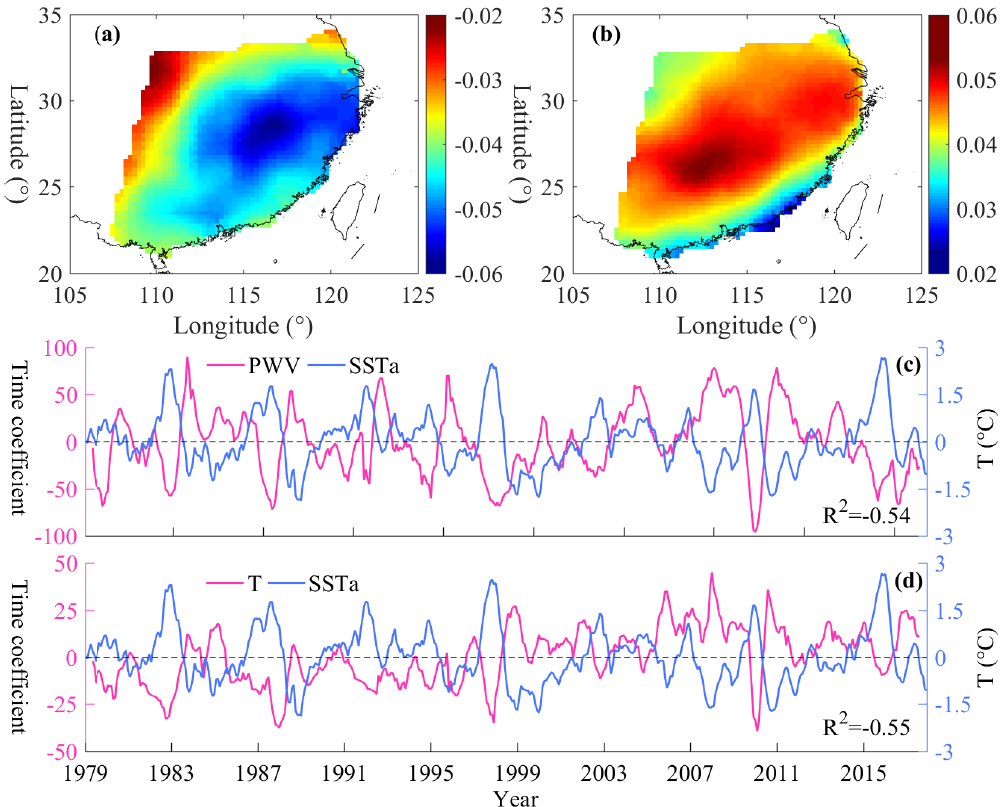
Figure 3. Spatiotemporal pattern of first mode in PWV and T, and compared with the time series of SSTA in Southeast China over the period of 1979 – 2017, where ( a ) and ( b ) are the spatial distributions of PWV and T first mode, respectively and ( c ) and ( d ) are the time series of time coefficients of PWV and SST first mode and SSTA, respectively.